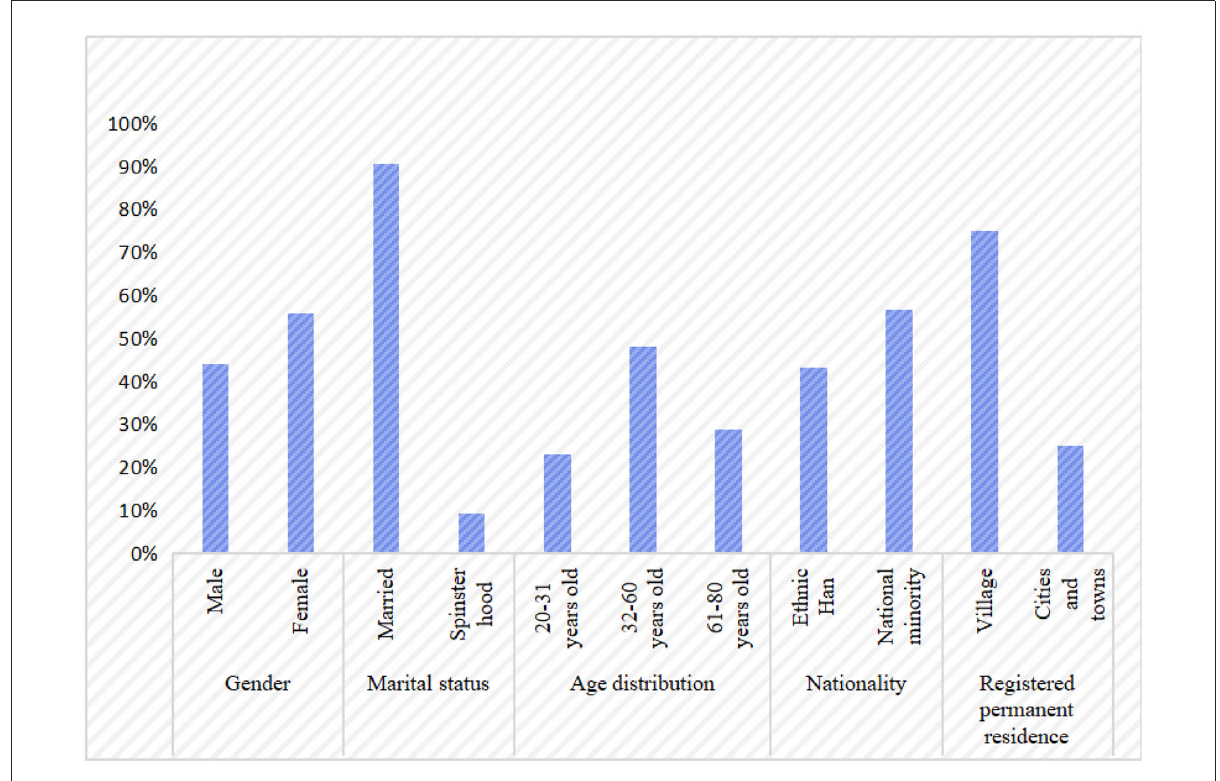
FIGURE2 Basic information of residents in those valid